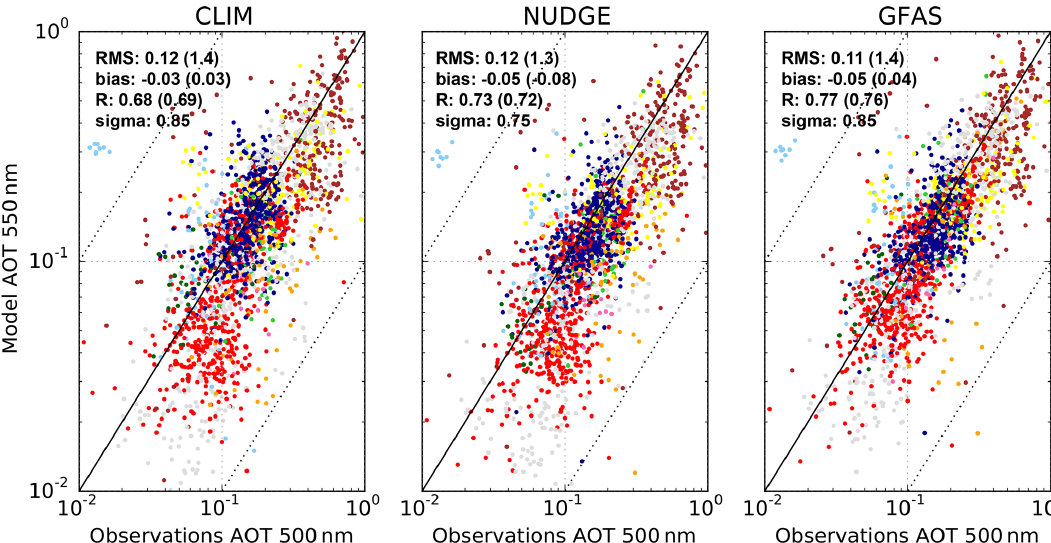
Figure 5. Scatterplots of observed versus simulated mean AOT over the period January 2003 to December 2012 at the AERONET stations shown in Fig. 1. The simulated yearly means are constructed by sampling the model from daily mean outputs for the same days of ob- servations and collocated to the locations of the observations. Stations are color coded depending on the regions to which they belong as shown in Fig. 1. Red: North America; dark blue: Europe; brown: East Asia; pink: Siberia; yellow: North Africa; green: South Africa; orange: South America; dark green: Australia; light blue: oceanic regions; grey: elsewhere (coastal and/or mixed). Compared are model results for the simulations described in Sect. 2.3. For each comparison the root mean square error (RMS; with normalized RMS in parentheses), the Pearson correlation coefficient ( R , shown on log scale in parentheses), the absolute bias (normalized bias), and the ratio between simulated and observed standard deviation (sigma) are